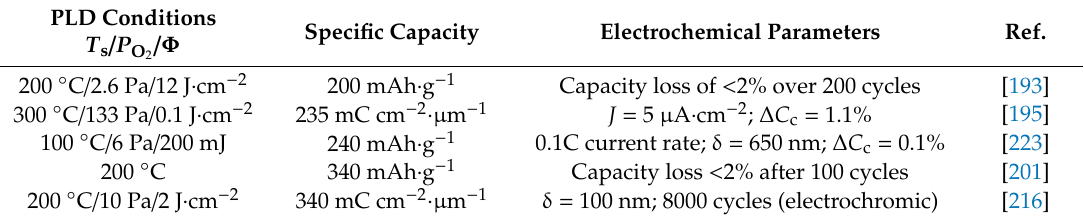
Table 7. Electrochemical properties of PLD-prepared vanadium oxide thin film electrodes. J is the current density, δ is the film thickness, and ∆ C c is the capacity fading per